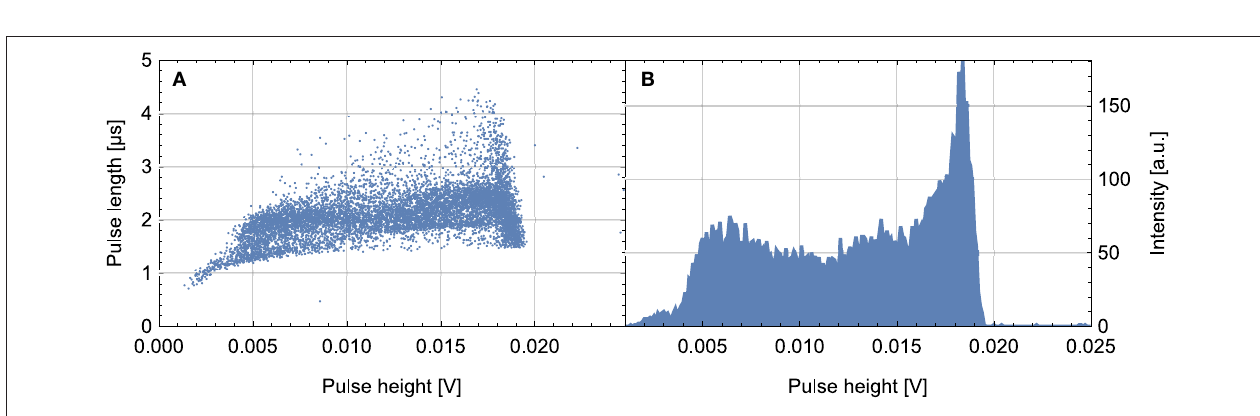
FIGURE 10 | Pulse shape analysis for a 3 He proportional counter. (A) Shows the pulse length and height plot and (B) the projected pulse height